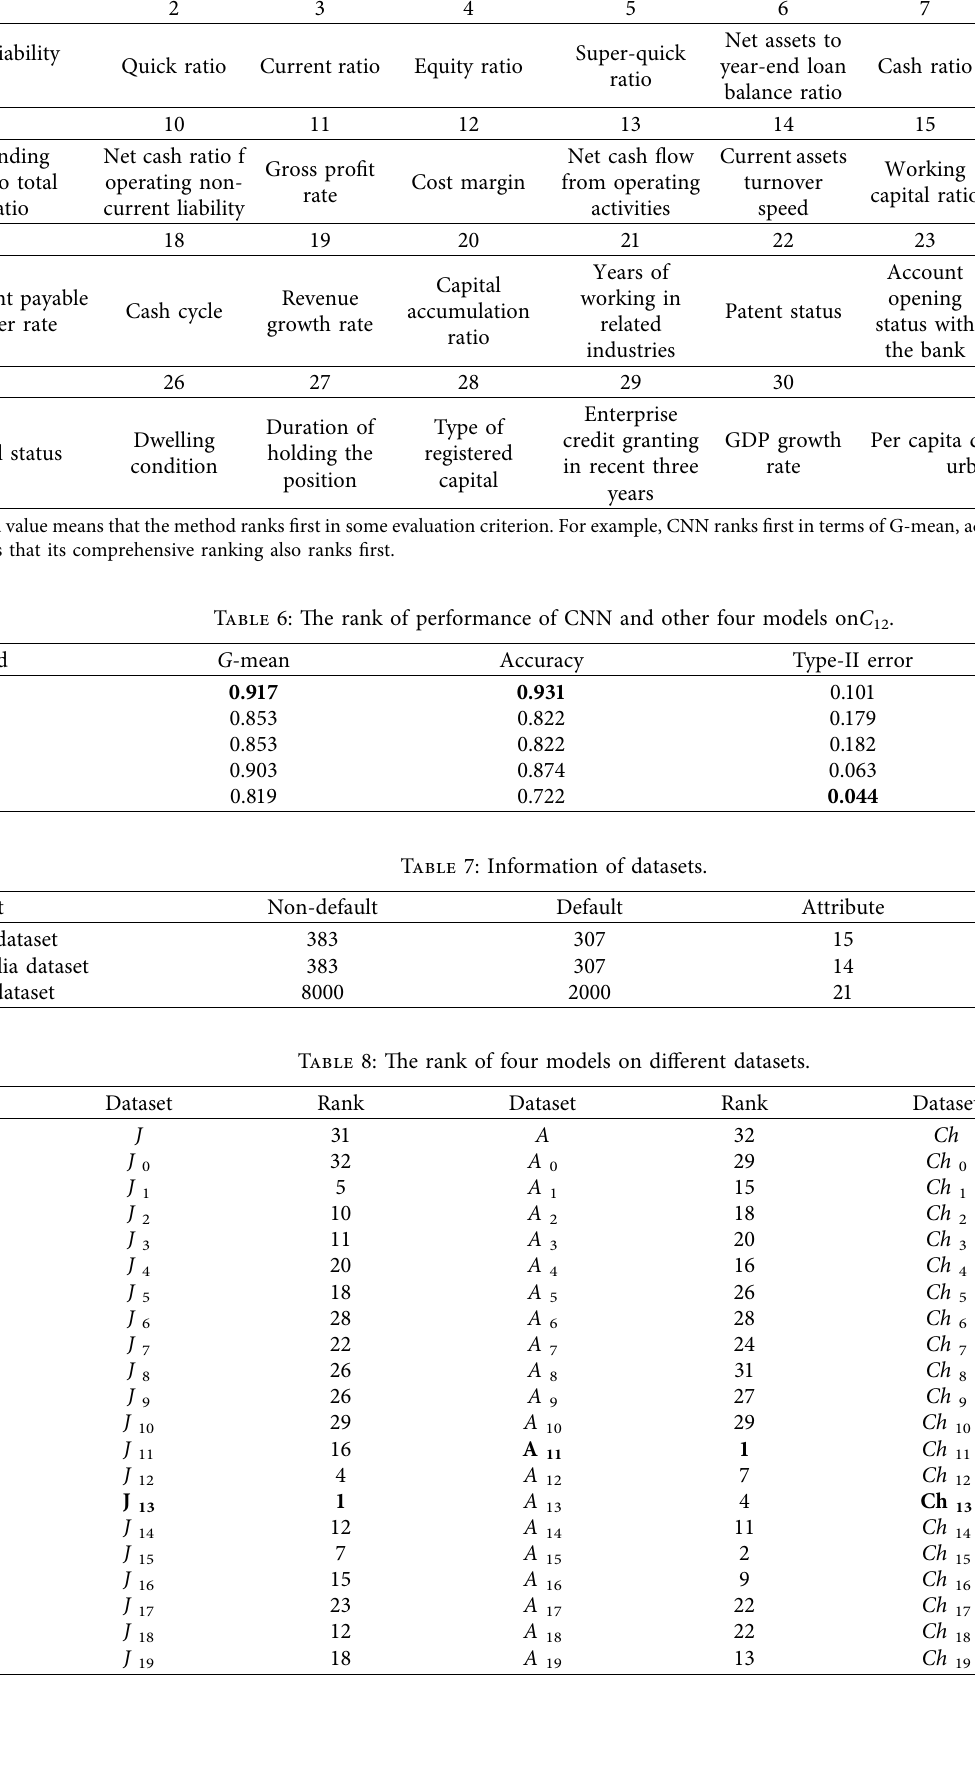
Table 5: Optimal feature combination system for small business default risk prediction.